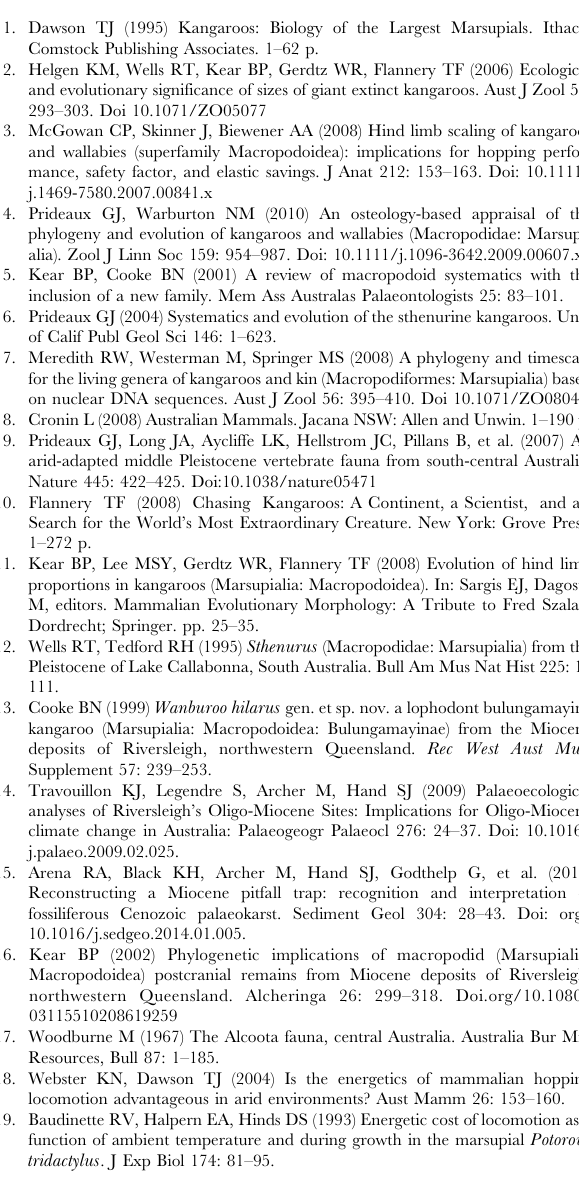
the taxa. Table A, Coefficient loadings for additional Discrim- inant Analysis for all of the taxa: all hind limb bones. Table B, Coefficient loadings for additional Discriminant Analysis for all taxa: without the